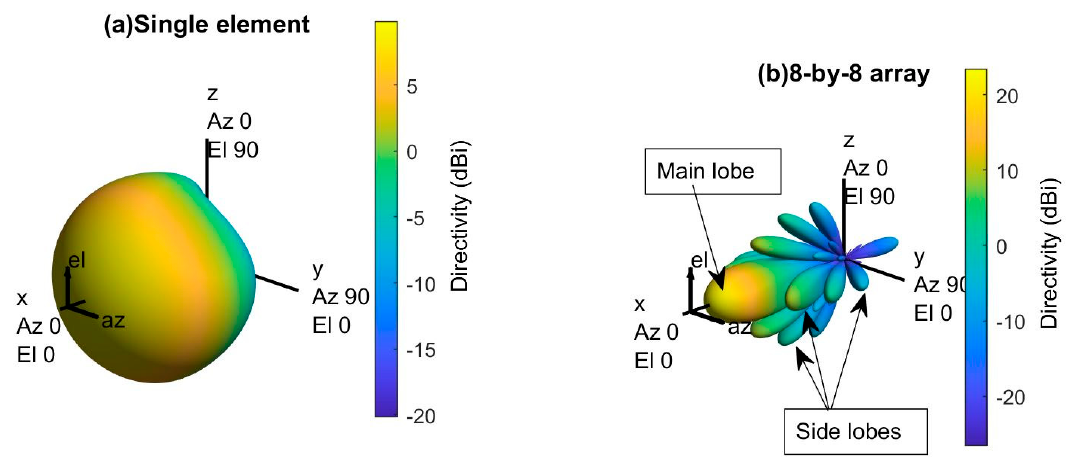
Figure 6. 3D radiation pattern of a single element and an 8-by-8 antenna array for 30 GHz operating frequency. The antenna array provides path diversity (also called MIMO), and the path diversity